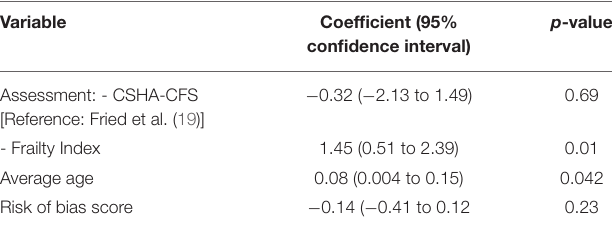
TABLE 3 | Meta-regression analysis of factors affecting heterogeneity (prevalence of frailty).